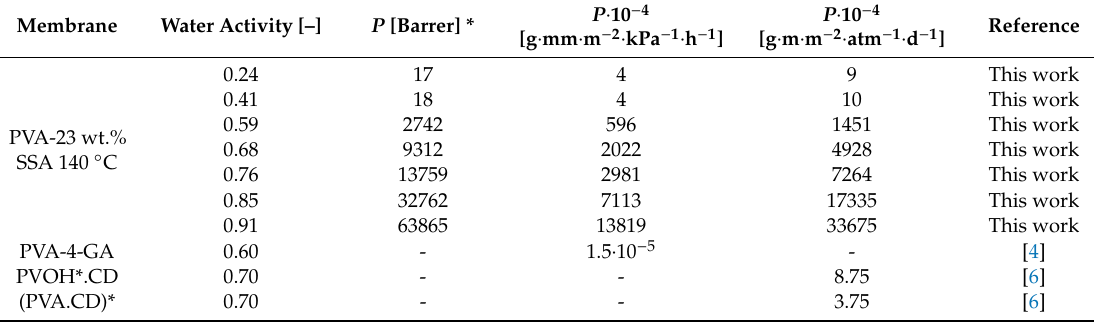
Table 5. Water vapor permeability coe ffi cients of the PVA